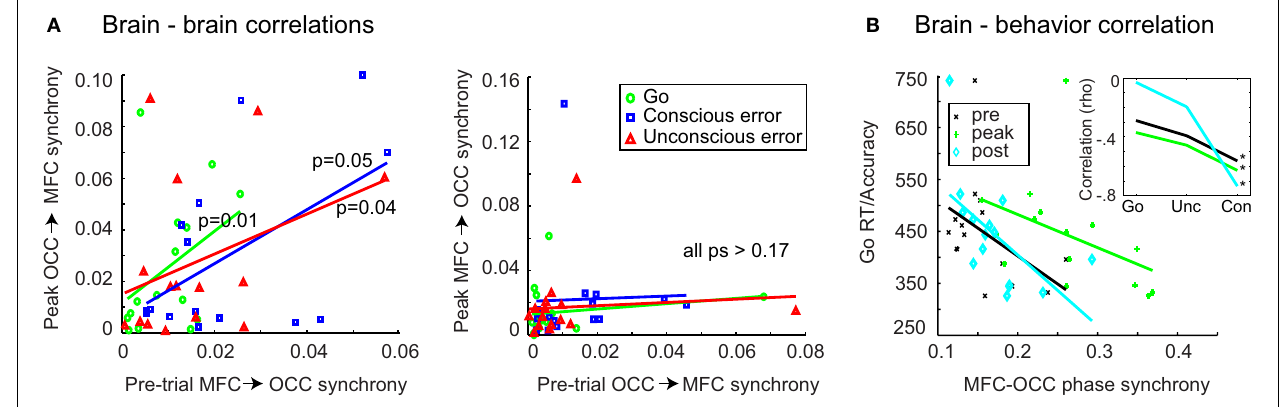
FIGURE 6 | Top-down synchrony predicts stimulus-related bottom-up synchrony and task performance. (A) Subjects with stronger pre-stimulus MFC → OCC directed synchrony also had stronger peak synchrony (100–300 ms) OCC → MFC directed synchrony. This was statistically signifi cant in all conditions (left panel). In contrast, pre-stimulus OCC → MFC directed synchrony was not signifi cantly correlated with MFC → OCC directed synchrony (right panel), demonstrating the specifi city of pre-trial top-down control. (B) Subjects with